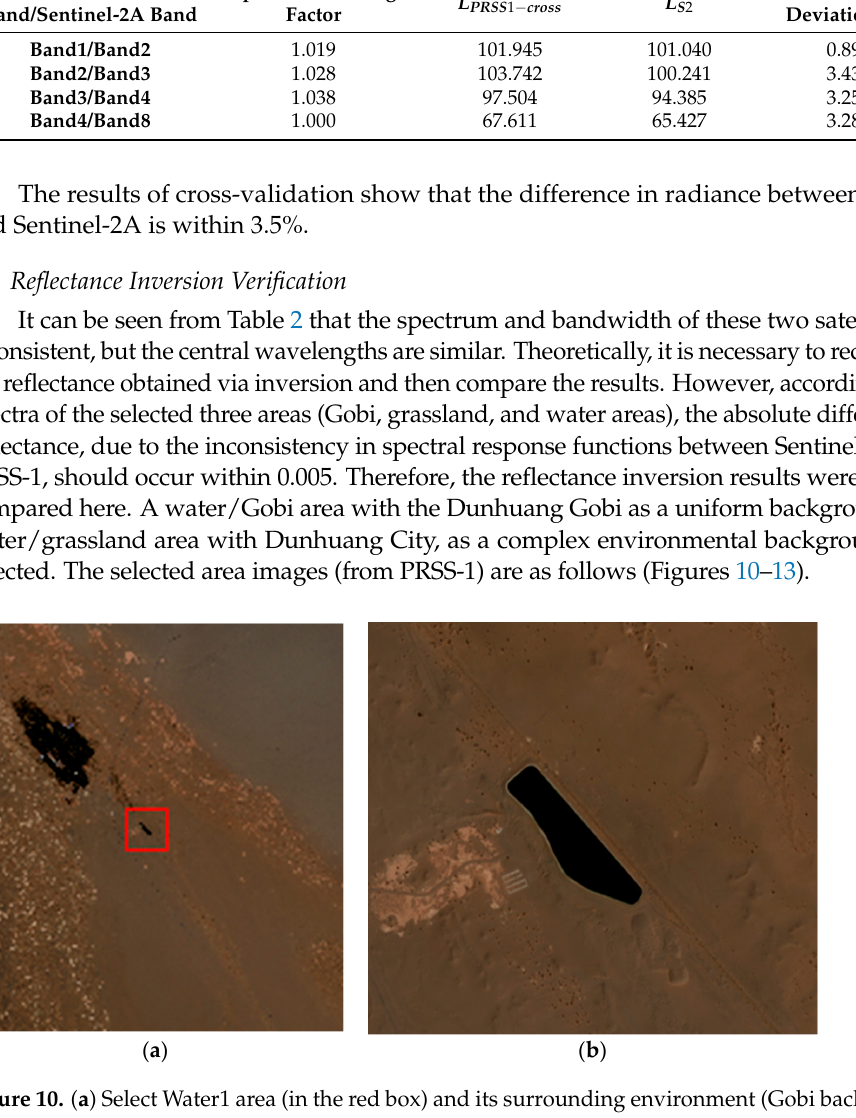
Table 3. Cross-validation results of PRSS-1 and Sentinel-2A. PRSS-1 Band/Sen-